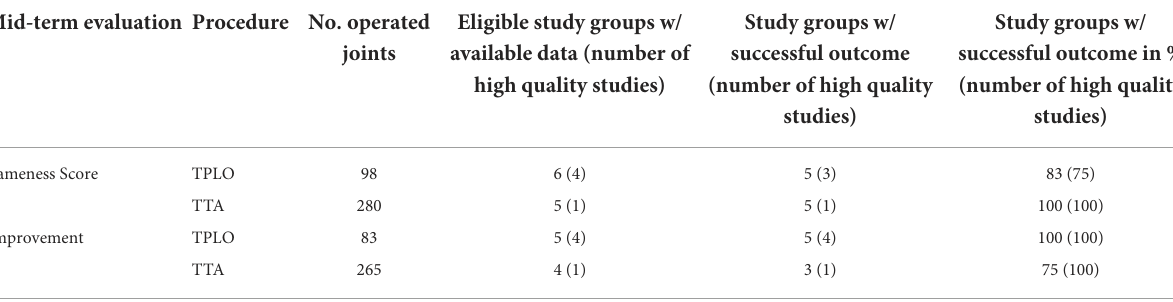
TABLE 4 Subjective lameness at mid-term